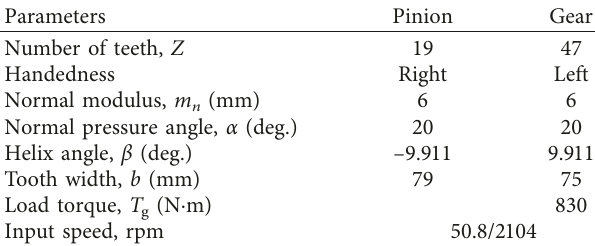
Table 1: Parameters of pair of helical